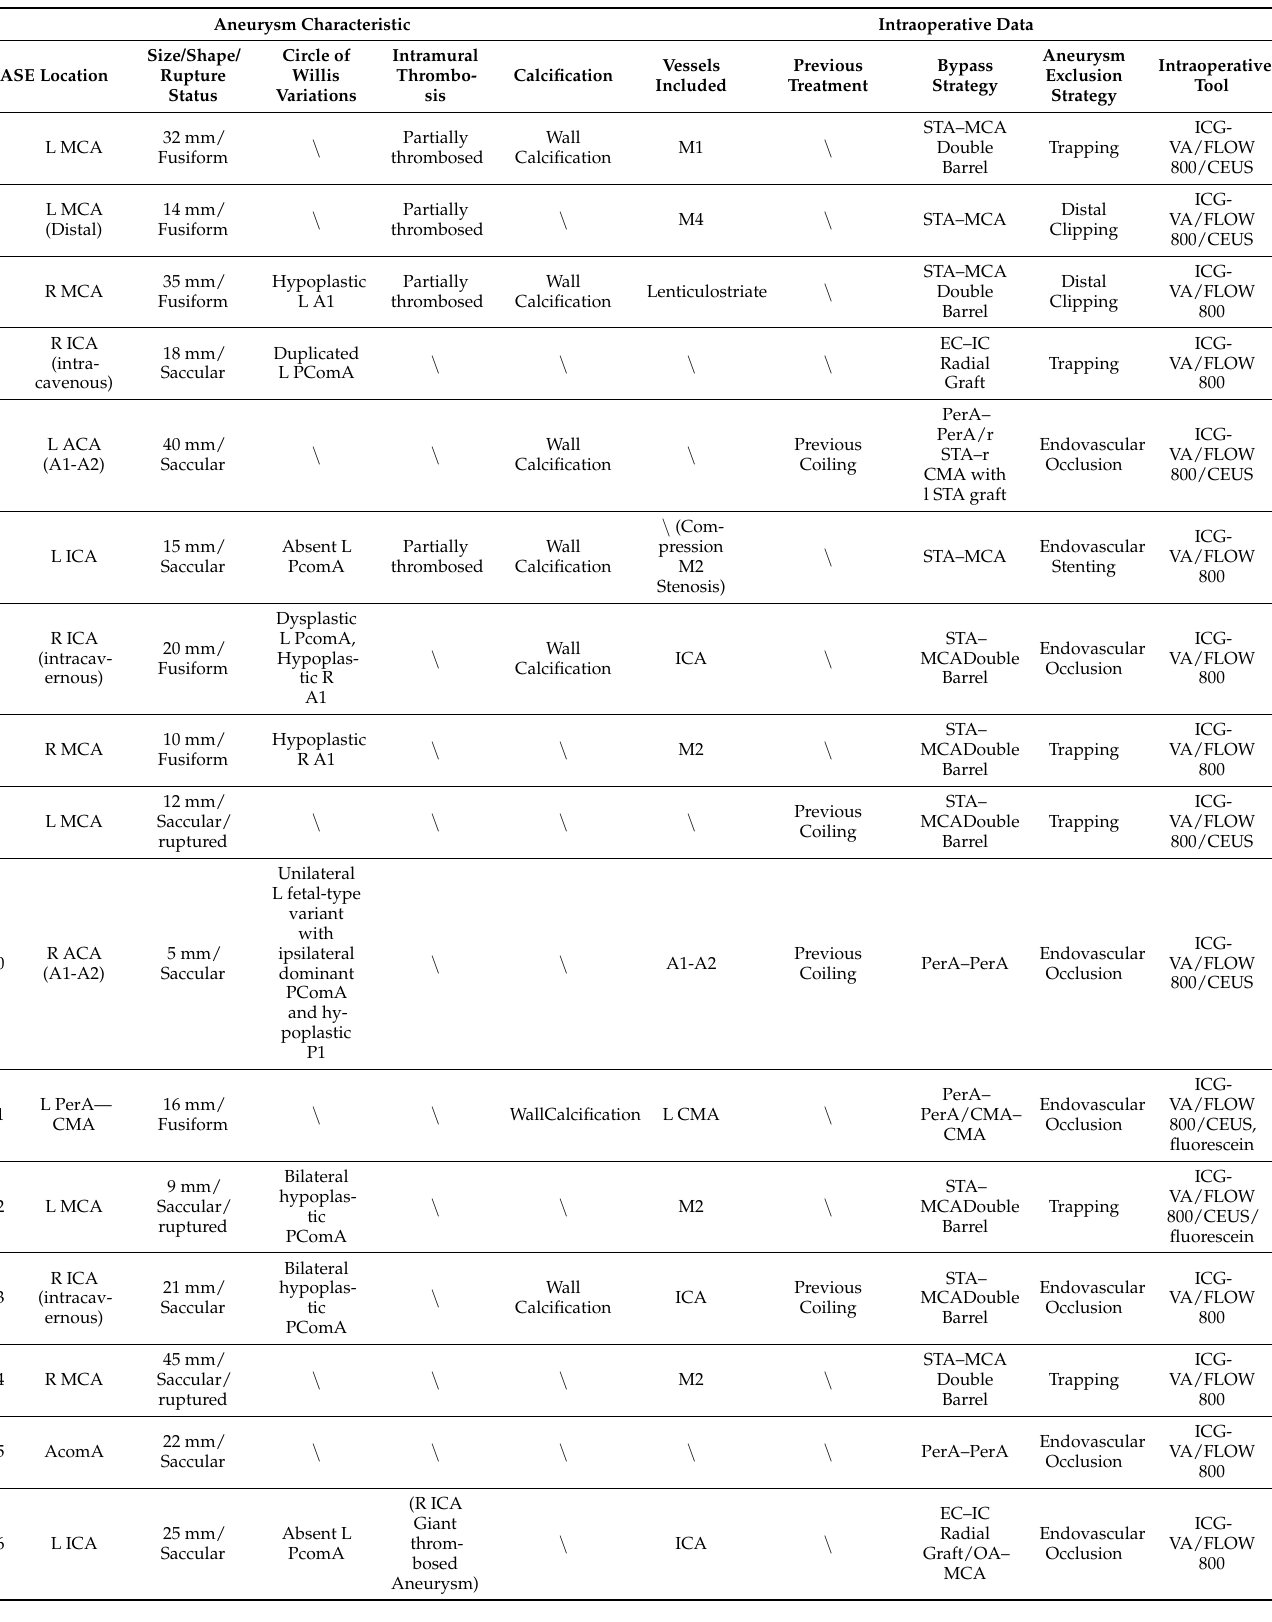
Table 1. Summary of aneurysm’s characteristics and Intraoperative